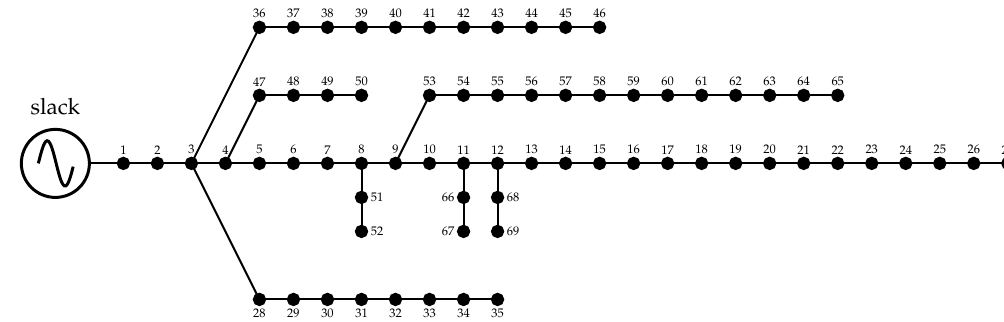
Figure 6. Electrical configuration of the 69-node test